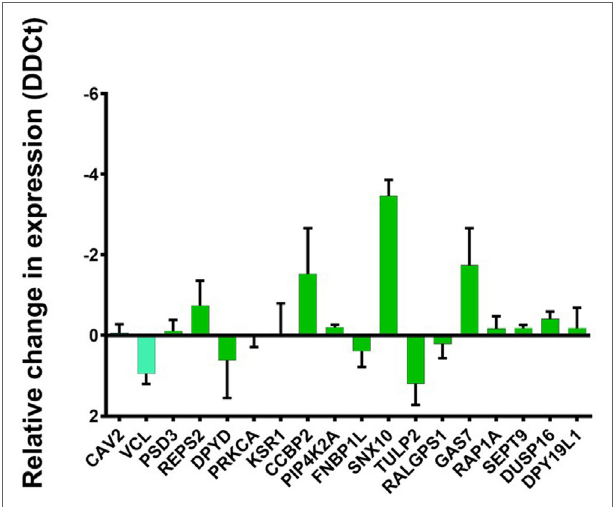
FigUre 5 | Change in relative expression levels of STAT1, autoimmune regulator (AIRE), and AIRE-dependent genes in TEC 1A3 AIRE hi cells treated with either anti-STAT1 or scrambled shRNA. The expression of STAT1, AIRE, and AIRE-dependent genes were normalized to β -Actin, compared against values from the appropriate untreated cells after introducing lentiviral vectors that produce either a control “scrambled” shRNA or an anti-STAT1 shRNA. Genes tested split into the following groups: AIRE and STAT1 expression are indicated in red and orange, respectively. Genes upregulated by AIRE that are U-STAT1 independent: CCL5 and CDKN1C (dark purple). Genes downregulated by AIRE and previously reported as STAT1 regulated: KRT17 (gray) (61). Conserved genes upregulated by AIRE that were previously reported to be U-STAT regulated: IFIT1, IFI44, IFIT3, OAS2, OAS1, IRF7, and NIPA1 (blue) (60). DUSP4 (purple) is a conserved gene downregulated by AIRE that has been reported to interact functionally with STAT1 (62).